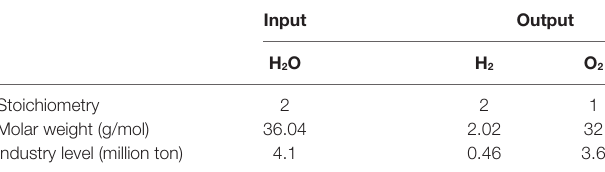
TaBle 5 | Overview of mass flows in electrolysis on a molar level and industry level for 2.5 million ton of CO 2 .